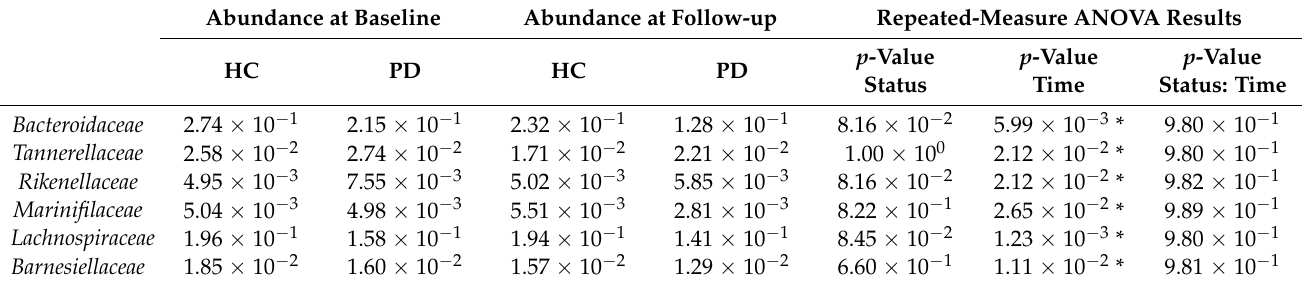
Table 2. Bacterial families identified by the repeated-measure ANOVA test. The relative abundance is reported for HC and PD patients at baseline and follow-up tests. The p -values reported refer to the significance between HC and PD patients (status), follow-up and baseline (time), or considering the effect of status and time. All the p -values are corrected for multiple